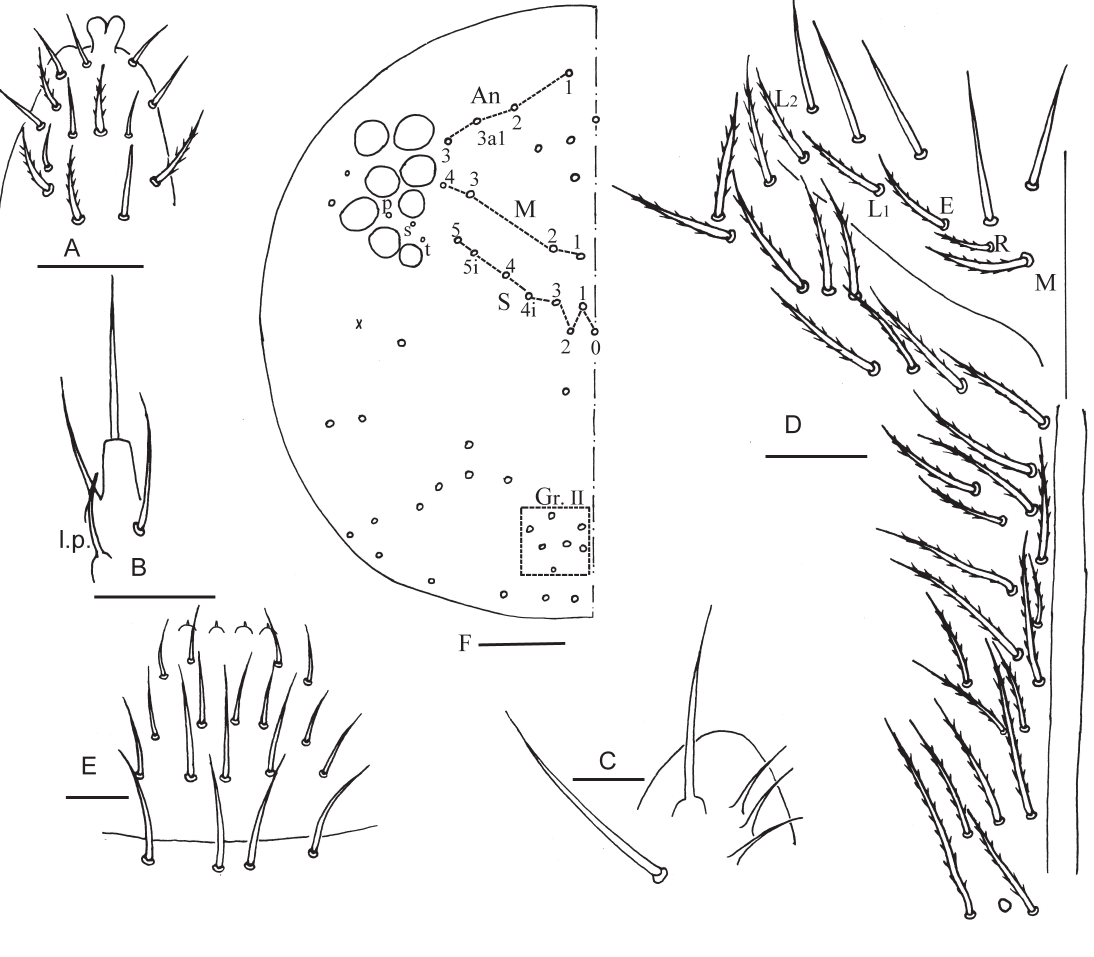
Fig. 2. Entomobrya leviseta sp. nov. A . Apex of Ant. IV. B . Lateral process of labial palp. C . Maxillary outer lobe. D . Labium. E . Labrum. F . Dorsal chaetotaxy of head. Scale bars: D, F = 50 μm; A–C, E = 20